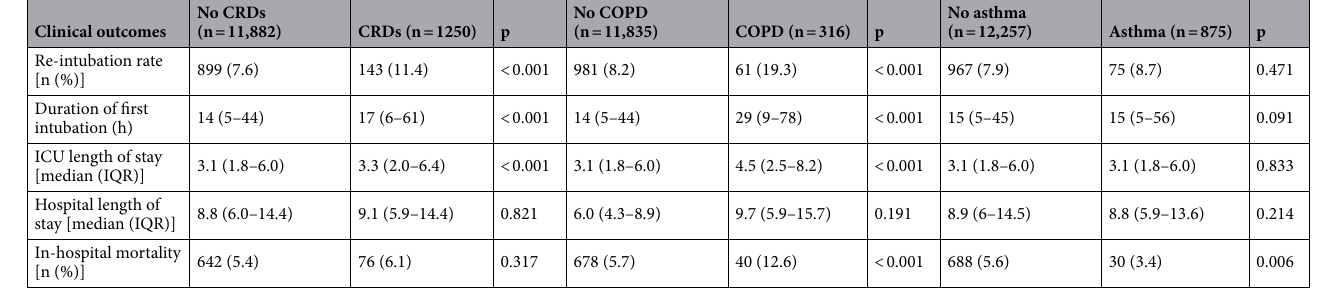
Table 2. Crude comparisons of clinical outcomes within different subgroups. CRDs chronic respiratory diseases, COPD chronic obstructive pulmonary disease, ICU intensive care unit, IQR inter quartile range.